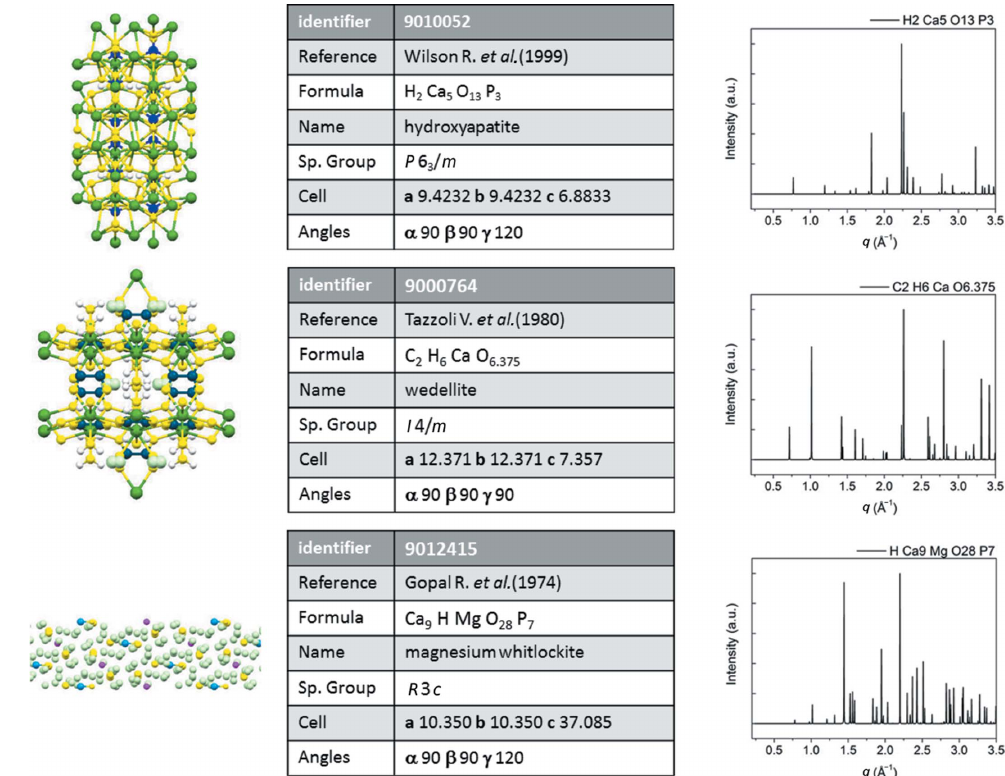
Figure 3 Potential crystal structures of nanocrystalline calcifications. Left column: atomic model; center column: details of the structures from COD database; right column: powder diffraction simulations for an X-ray energy of 13.6